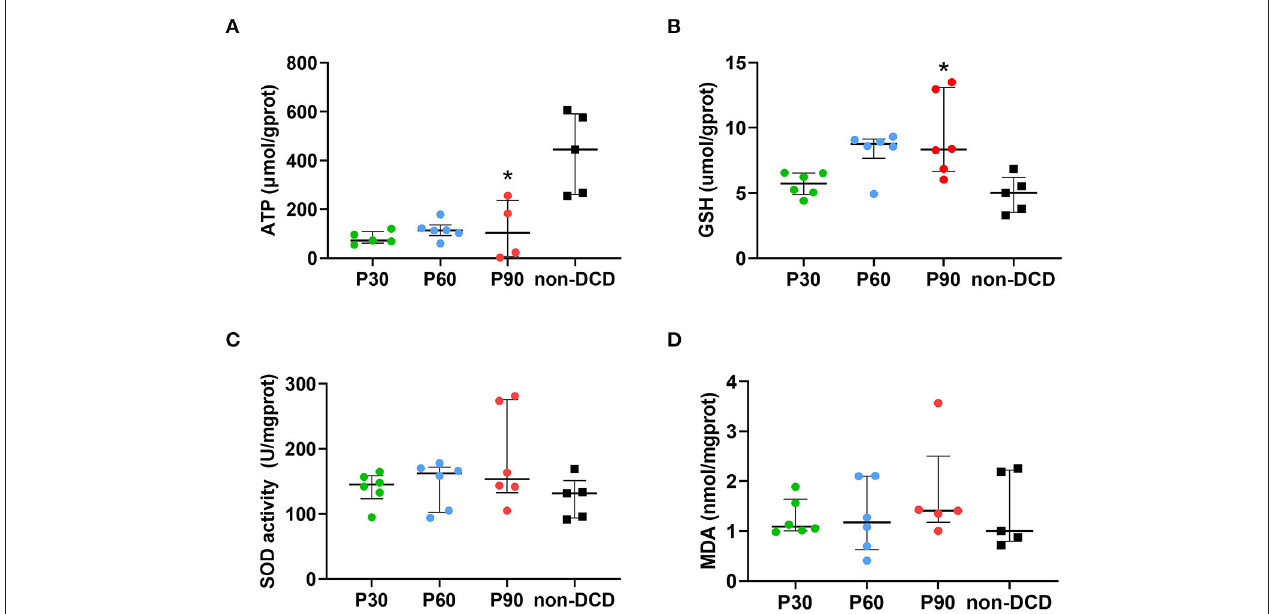
FIGURE 4 | Tissue content of ATP, GSH, MDA, and SOD activity in the donor heart during ESHP. (A) ATP. n = 5 for P30 group and non-DCD group, n = 6 for P60 group, n = 4 for P90 group; (B) GSH. n = 6 for P30, P60, and P90 groups, n = 5 for non-DCD group; (C) SOD activity. n = 6 for P30, P60, and P90 groups, n = 5 for non-DCD group; (D) MDA. n = 6 for P30 and P60 groups; n = 5 for P90 group and non-DCD group. Data represented as median and interquartile range. ATP, Adenosine triphosphate; DCD, Donation after circulatory death; ESHP, Ex situ heart perfusion; GSH, Glutathione; MDA, Malonaldehyde; SOD, Superoxide dismutase. * p < 0.05 vs. non-DCD